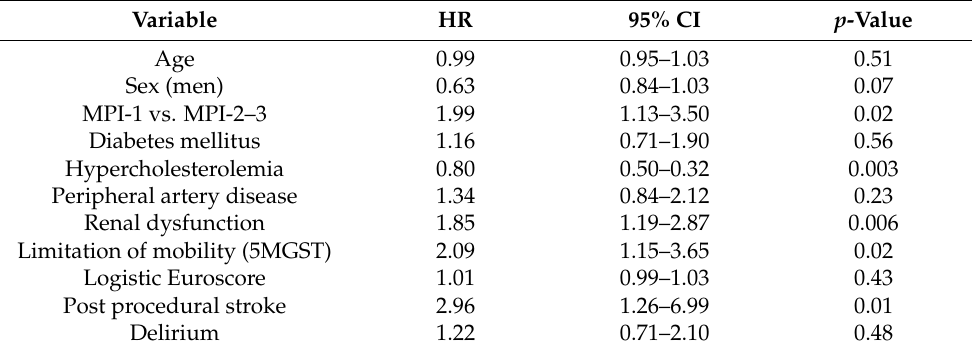
Abbreviations used: MPI, multidimensional prognostic index; 5MGS, 5 meter gait